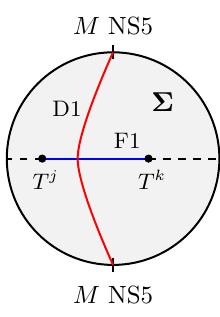
Figure 7 . Disc representation of the + N;M;k;j solution. The straight horizontal blue line represents a fundamental string stretching between the D7-brane punctures, the solid red curve represents a D1 brane stretching between the NS5-brane